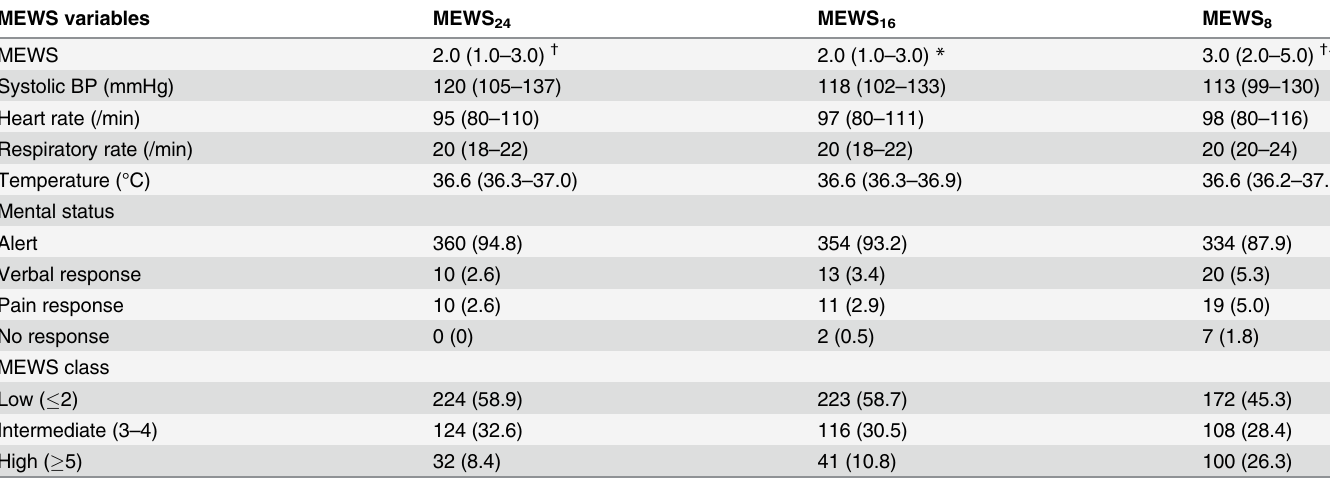
Table 3. Changes in the Modified Early Warning Score (MEWS) and Physiological Parameters.